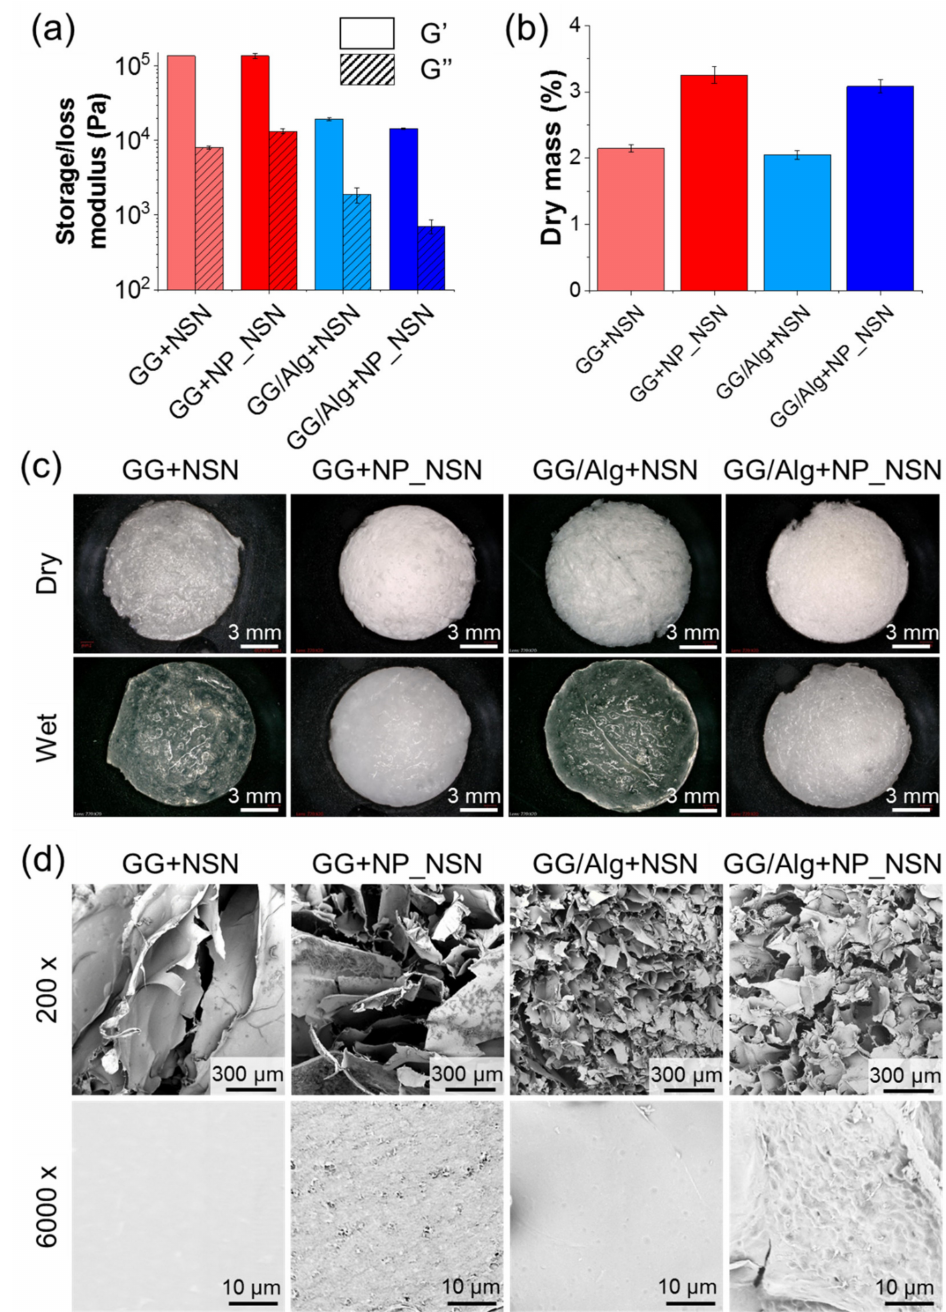
Figure 3. Physico-chemical characterization of GG and GG/Alg hydrogels containing NSN or NP_NSN: rheological characteristics ( a ), dry mass percentage ( b ), gross morphology in dry and hydrated (wet) state ( c ) and SEM images at magnification of 200 × and 6000 × ( d